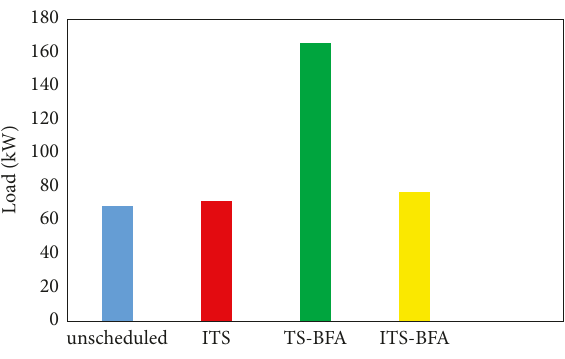
Figure 6: Load before and after scheduling.